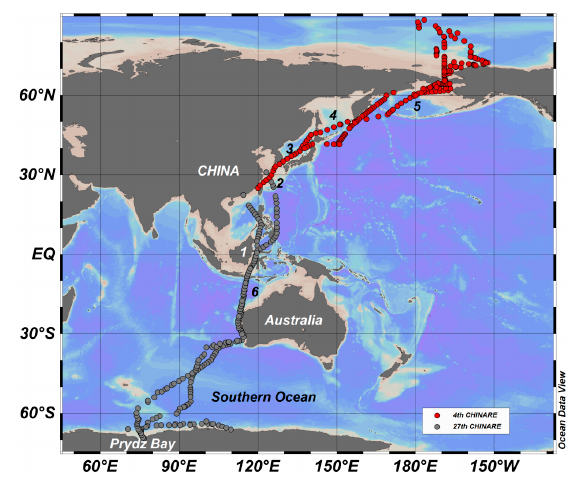
Figure 1. The cruise tracks of the 4th Chinese National Arctic Research Expedition and the 27th Chinese Antarctic Research Expedition. The background color of the map is